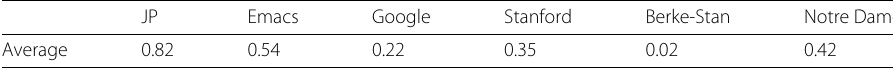
Table 5 Average values of the locality